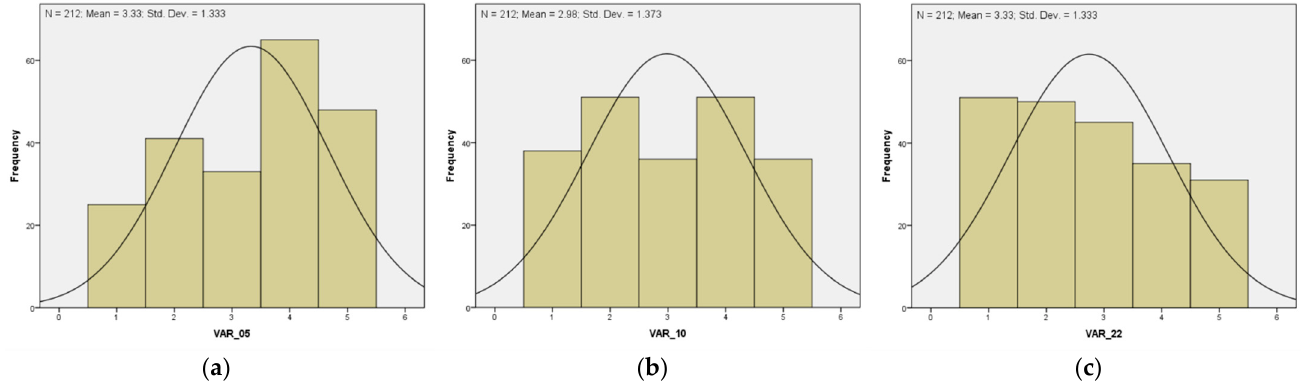
Figure 1. Excluded variable histograms: ( a ) VAR_05; ( b ) VAR_10; and ( c ) VAR_22.